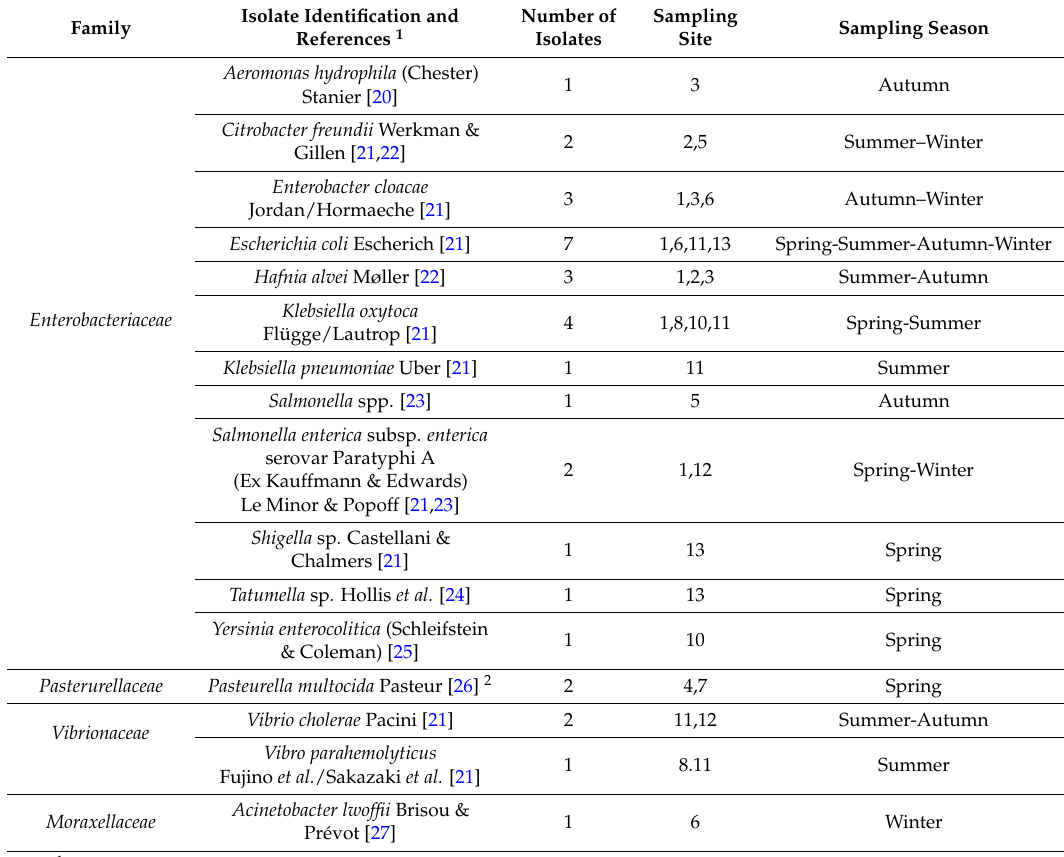
Table 2. Identified bacterial isolates recovered from freshwater at Bassaseachic Falls National Park during